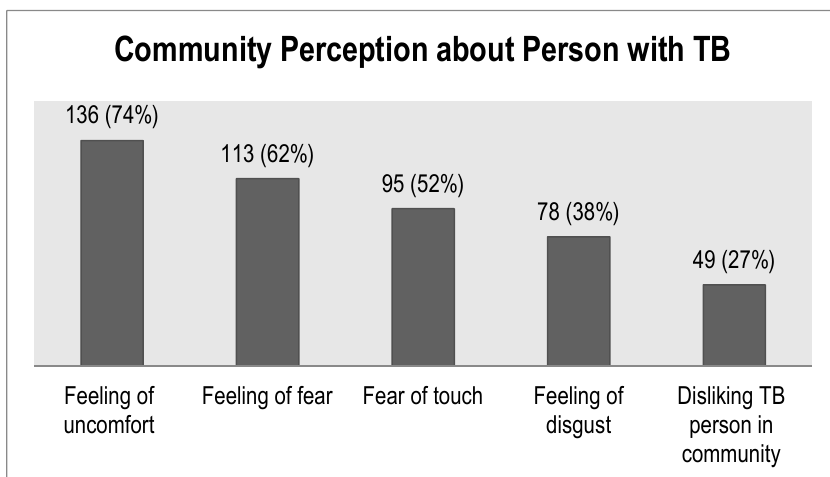
Figure 1. Community perception about person with tuberculosis. Table 2. Level of perceived stigma associated with tuberculosis.